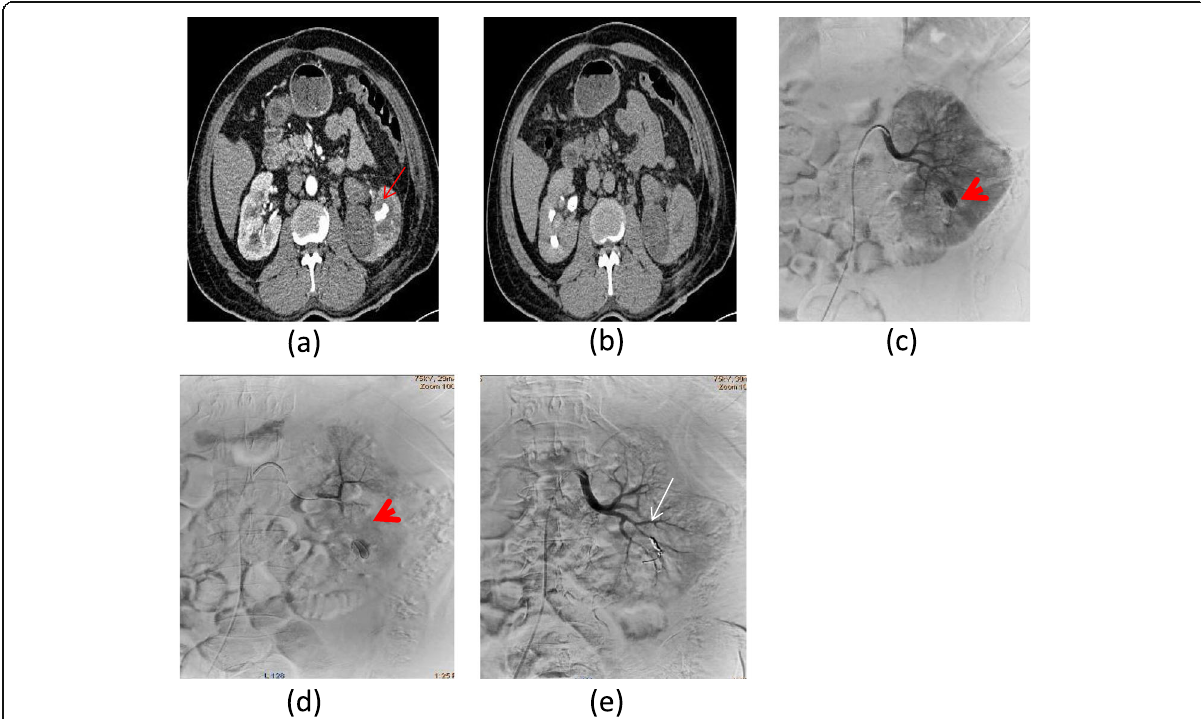
Fig. 1 Pre-embolization CT ( a , b ) of a 63-year-old man who presented with bleeding after PCNL showing aneurysmal extravasation (arrow) in the left kidney. Angiography revealed a pseudoaneurysm at the lower zone of the kidney (arrow head) ( c , d ). After super-selective catheterization with Progreat microcatheter, a micro-coil was inserted. The post-embolization DSA ( e ) showed obliteration of the aneurysmal sac with its sub- segmental feeder by the coil (white arrow) ( e